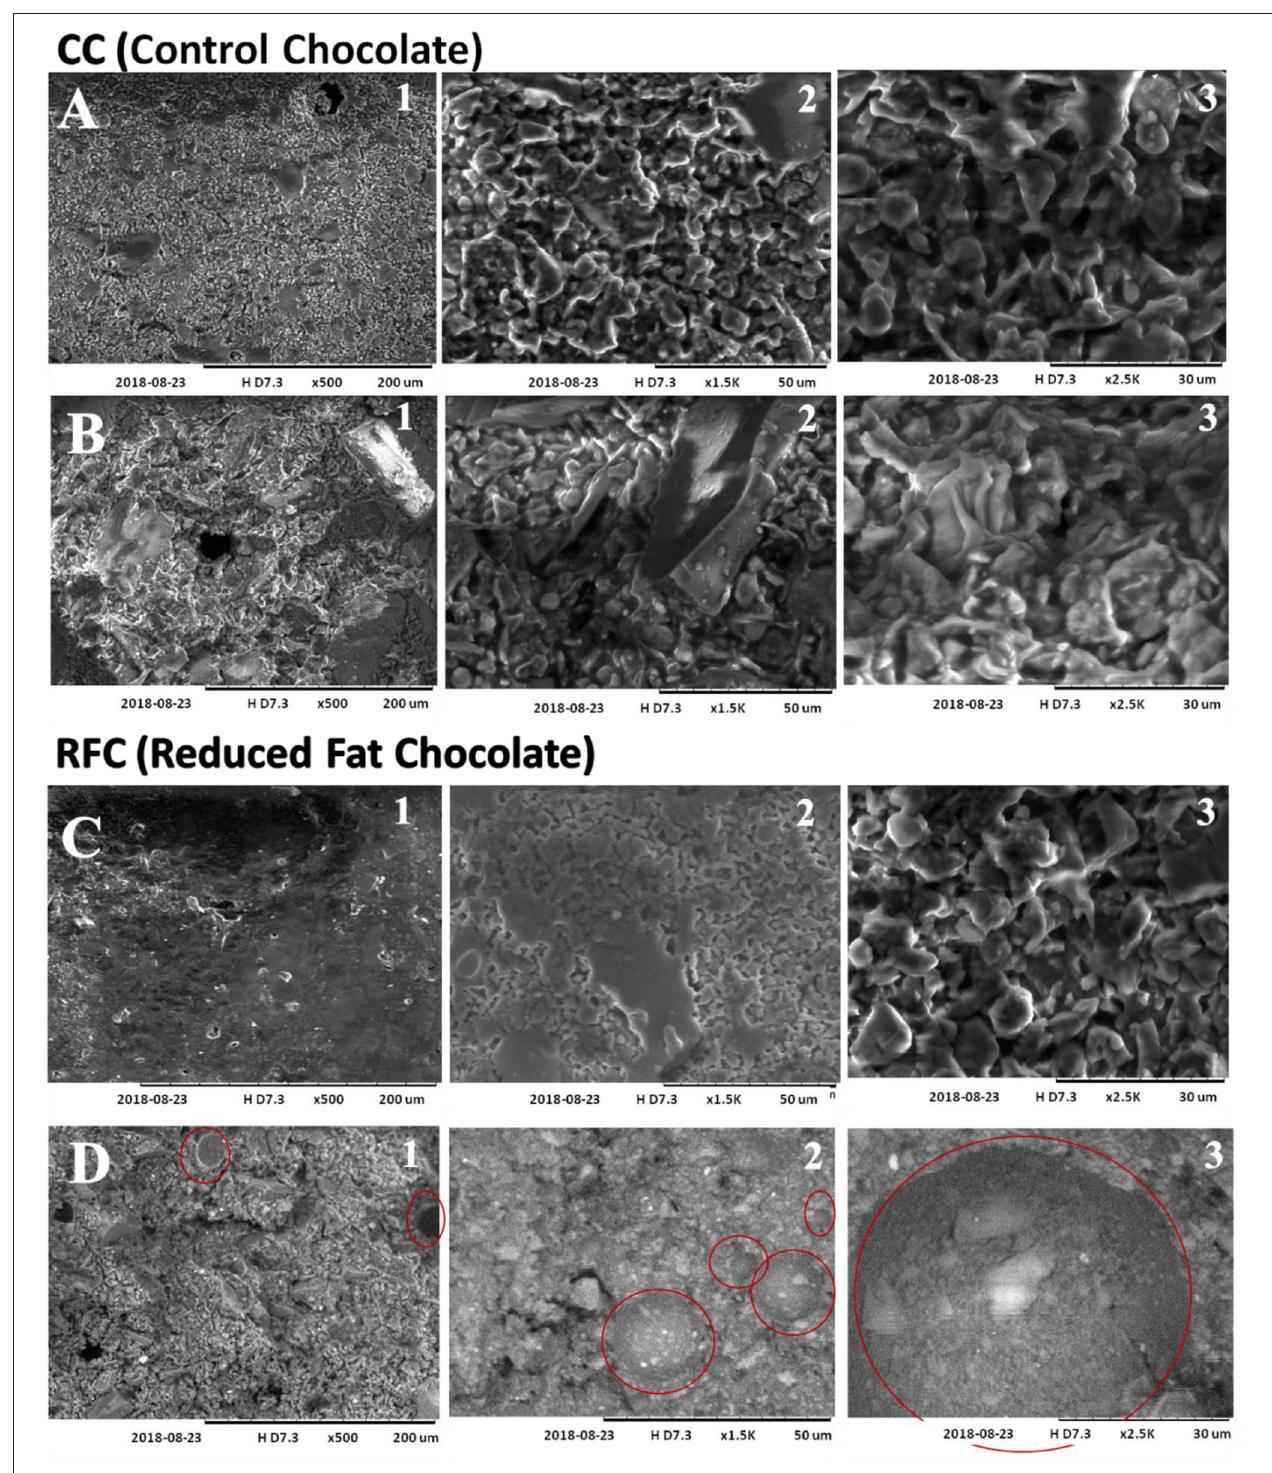
FIGURE 7 | Optical micrograph of control chocolates (CC) and reduced fat chocolate (RFC): Surface (A,C) ; Cross section (B,D) in three different increments 500 (1), 1,500 (2), and 2,500 (3) on day 1 of × ×